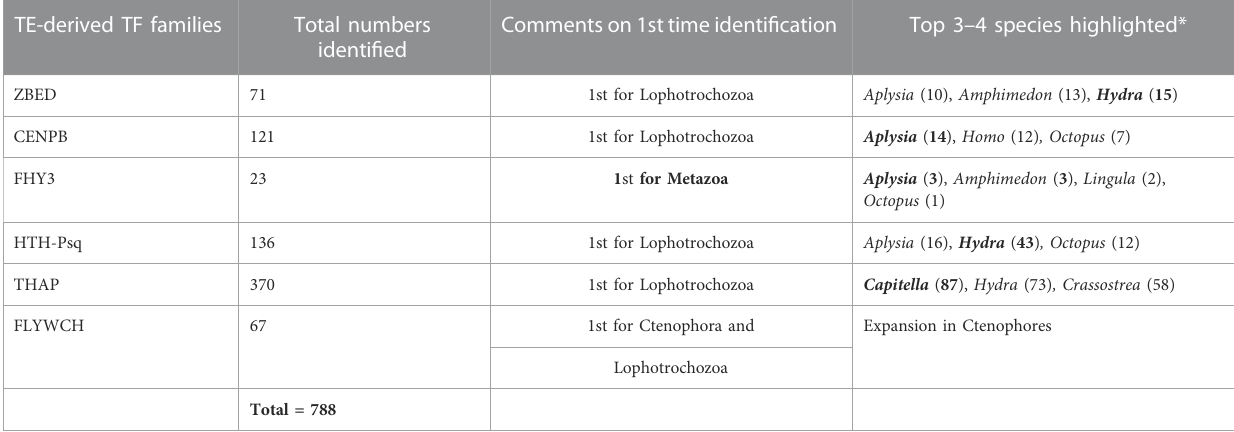
TABLE 1 The total number of potentially TE-derived TFs identi fi ed in this study. (See Figure 1; Supplementary Table S1 for